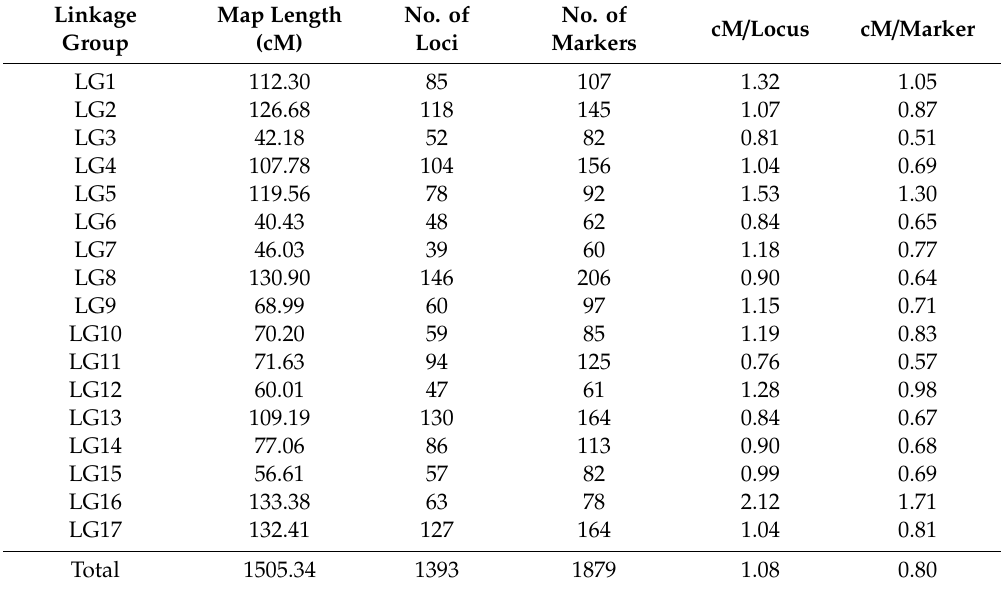
Table 3. Summary of sunflower linkage map developed using single nucleotide polymorphism (SNP) markers in the HA 89 / HA-R3 recombinant inbred line